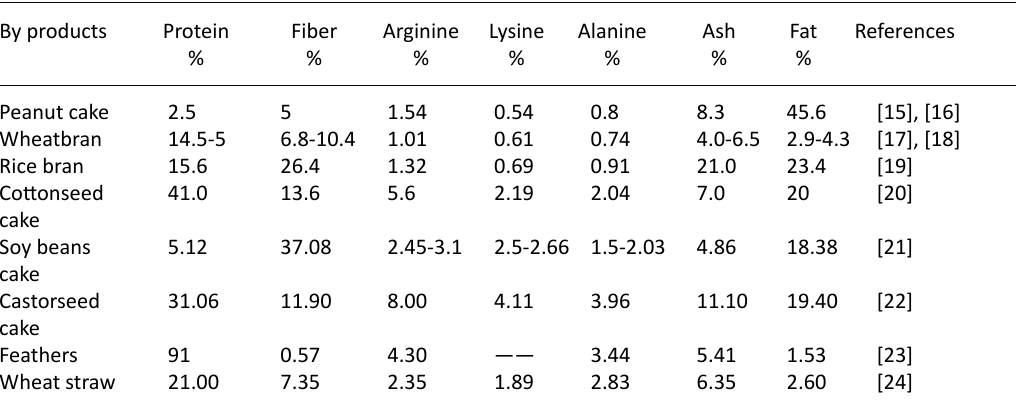
Table 1. Chemical structure of the experimental natural solid substrate By products Protein Fiber